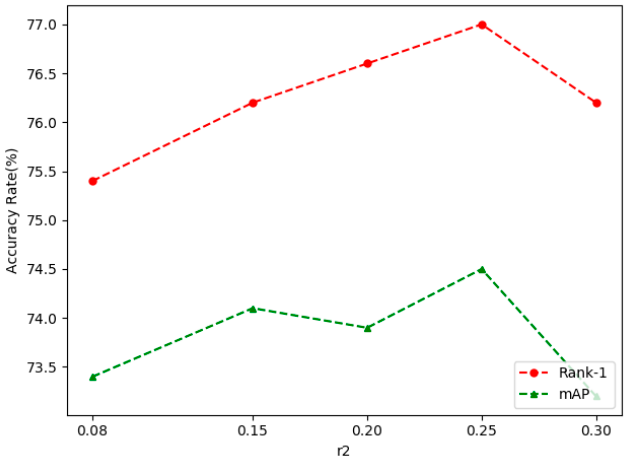
Figure 9. The effect of r2 on model performance.